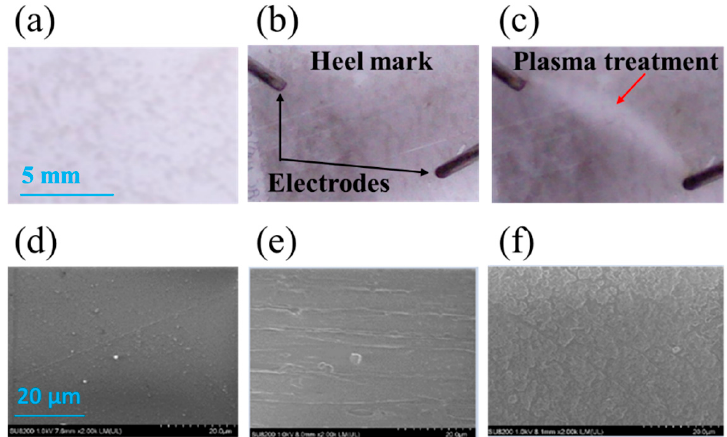
Figure 3. Photographs and SEM results on floor surface with HMs. ( a ) Unmarked (control) floor surface, ( b ) HMs bonded to the floor surface with two electrodes placed 10 mm apart, and ( c ) the floor tile during the plasma treatment. The SEM images were taken at magnification of 2000. ( d ) Unmarked (control) floor surface, ( e ) HMs bonded to the floor surface, and ( f ) the floor surface after HM removal of plasma treatment for 60 s.